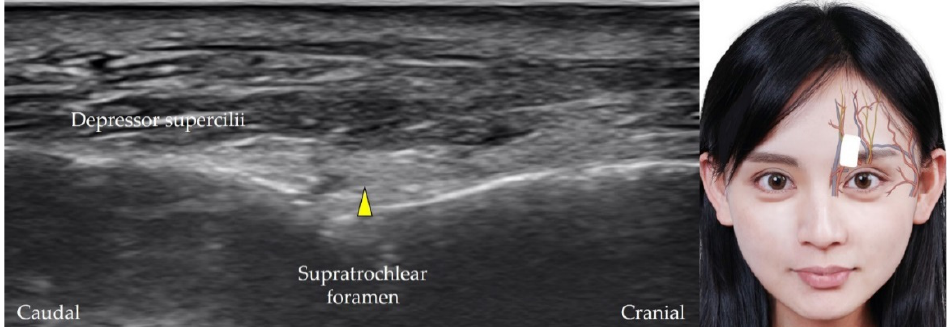
Figure 5. Ultrasound imaging of the supratrochlear nerve (yellow arrowhead) . White square , footprint of the ultrasound transducer.